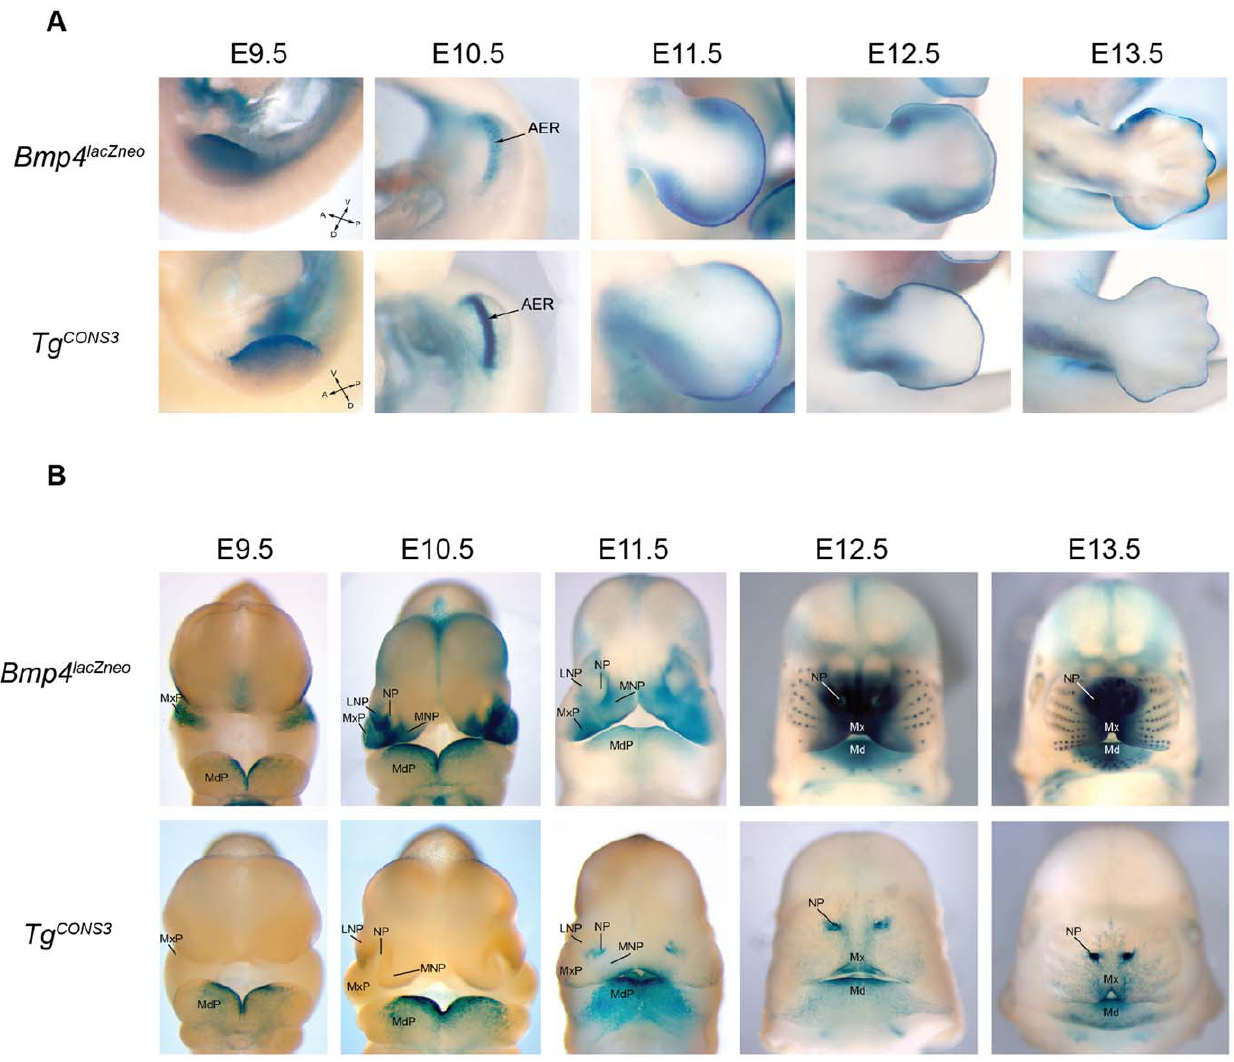
Figure 3. Bmp4 lacZneo and Tg CONS3 b -galactosidase activity in the limb and orofacial region. ( A ) Lateral views of developing fore- or hindlimbs of Bmp4 lacZneo control mouse embryos ( upper row ). Tg CONS3 transgenic embryos from permanent transgenic line TL3459 ( lower row). The CONS3 transgene expression largely recapitulates endogenous Bmp4 expression in the AER from E9.5–13.5. ( B ) Frontal views of the developing head of Bmp4 lacZneo and Tg CONS3 transgenic embryos from permanent line TL3459. From E9.5 to E11.0, Bmp4 is expressed in the epithelium overlying the distal first branchial arch, maxillary and mandibular processes and medial and lateral nasal processes. At these stages, the CONS3 enhancer recapitulates endogenous expression in the ectoderm overlying the distal part of the first branchial arch at E9.5 and the mandibular process at E10.5. At E12.5, endogenous Bmp4 expression shifts to the mesenchyme, while CONS3 expression persists in the epithelium overlying the mandibular arch and premaxilla, including incisor tooth germs. At E12.5 and 13.5, endogenous Bmp4 is concentrated in the mesenchyme of the midface including the whisker follicles. CONS3 transgene expression persists in the epithelium that overlies the mandible, pre-maxilla and nasal pits, and fails to shift to the underlying mesenchyme. Abbreviations: MxP, maxillary process; MdP, mandibular process; MNP, medial nasal process; LNP, lateral nasal process; NP, nasal pit; Mx, maxilla; Md, mandible.